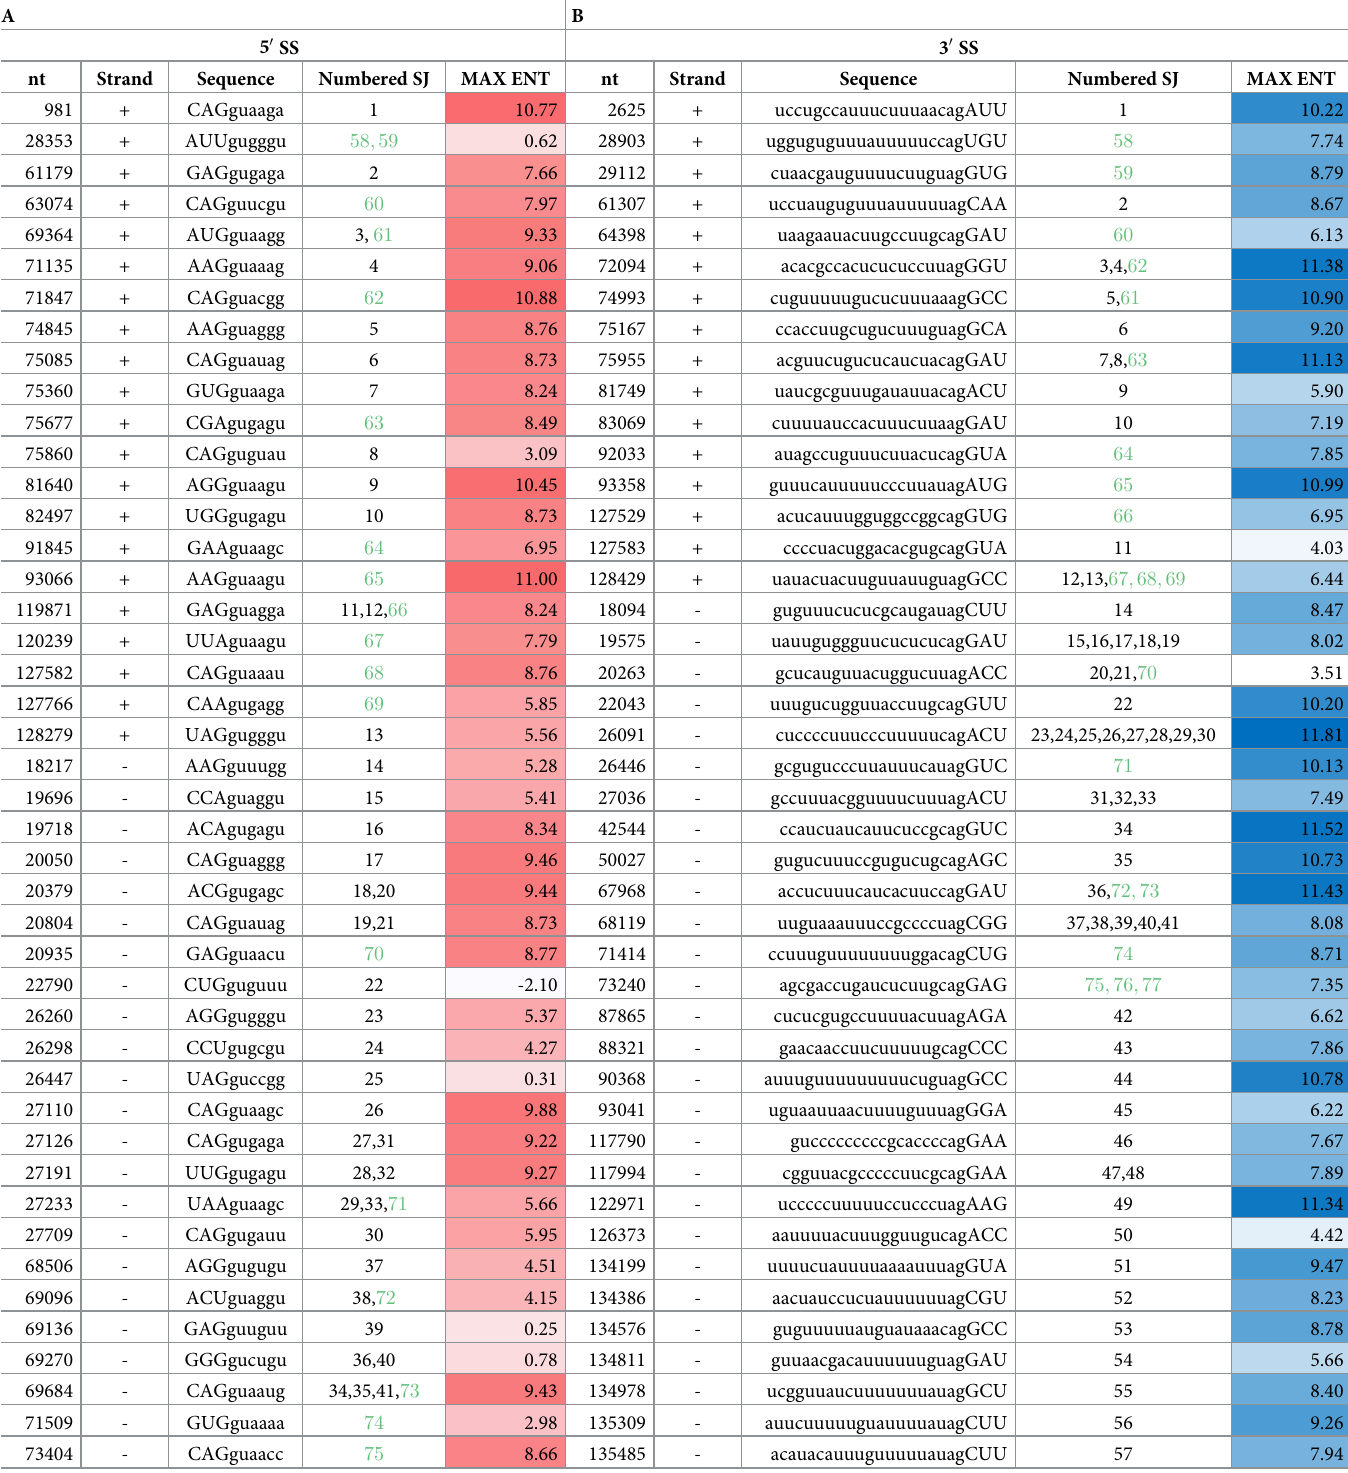
Table 2. The sequence and strength of identified KSHV splice sites. The position and sequences of KSHV 5 0 (A) and 3 0 (B) splice sites (SS) of splice junction (JS) with � 10 splice reads. The numbered splice junctions (SJ) are shown in Figs 3, 4 and 6 (see Tables 1 and 3 for more details). In green color are the numbered splice junctions with � 10 reads identified only in the 57KO genome. The strength (colored gradient) of individual SS was determined by MAX:ENT model [32]. A